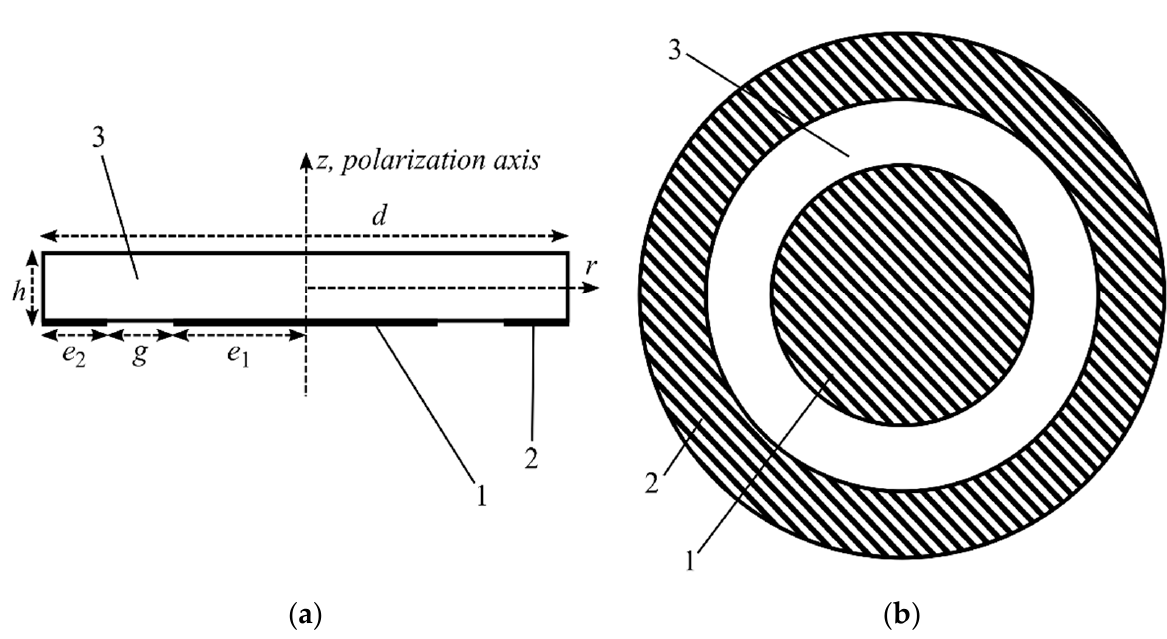
Figure 1. The geometry of the problem. ( a ) Side view of the resonator and ( b ) bottom view of the resonator; 1—internal electrode; 2—external electrode; 3—piezoceramic.